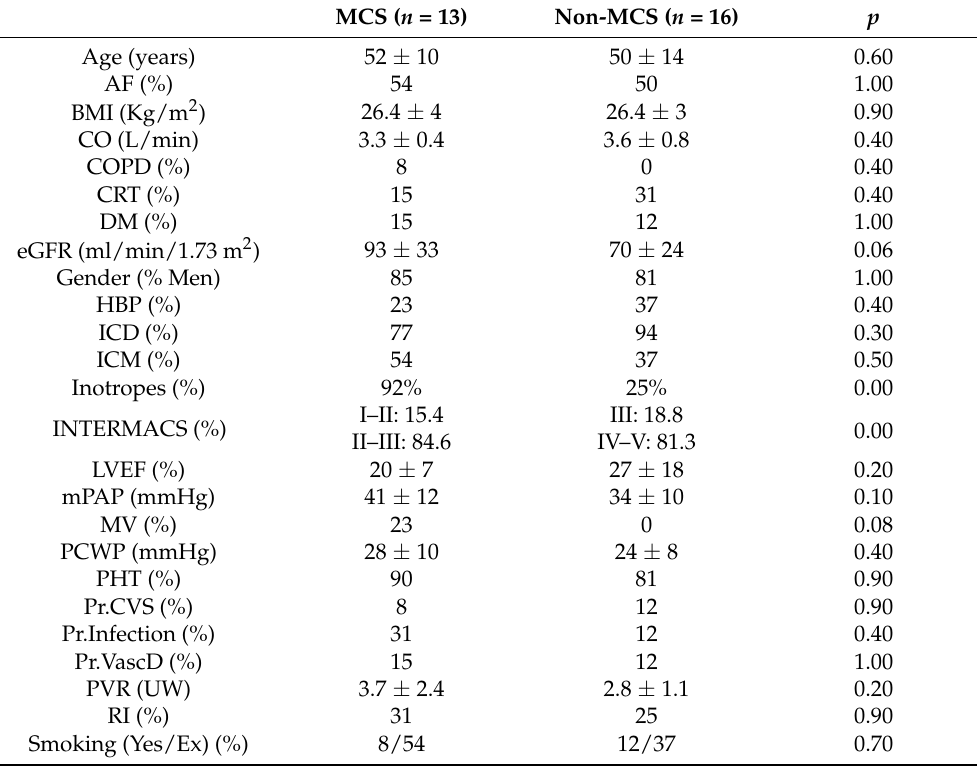
Values for continuous variables with a normal distribution are represented as the mean ± standard deviation while continuous variables with a paranormal distribution are represented by the median ± interquartile range. Discrete variables are described using percentages. AF: atrial fib- rillation or atrial flutter. BMI: body mass index kg/m 2 . CO: cardiac output. COPD: chronic obstructive pulmonary disease. CRT: cardiac-resynchronization therapy. DM: diabetes mellitus. eGFR: estimated glomerular filtration rate using the CKD-EPI equation (mL/min/1.73 m 2 ). HBP: high blood pressure. ICD: implantable cardioverter- defibrillator. ICM: ischemic cardiomyopathy. LVEF: ejection fraction of the left ventricle. MCS: